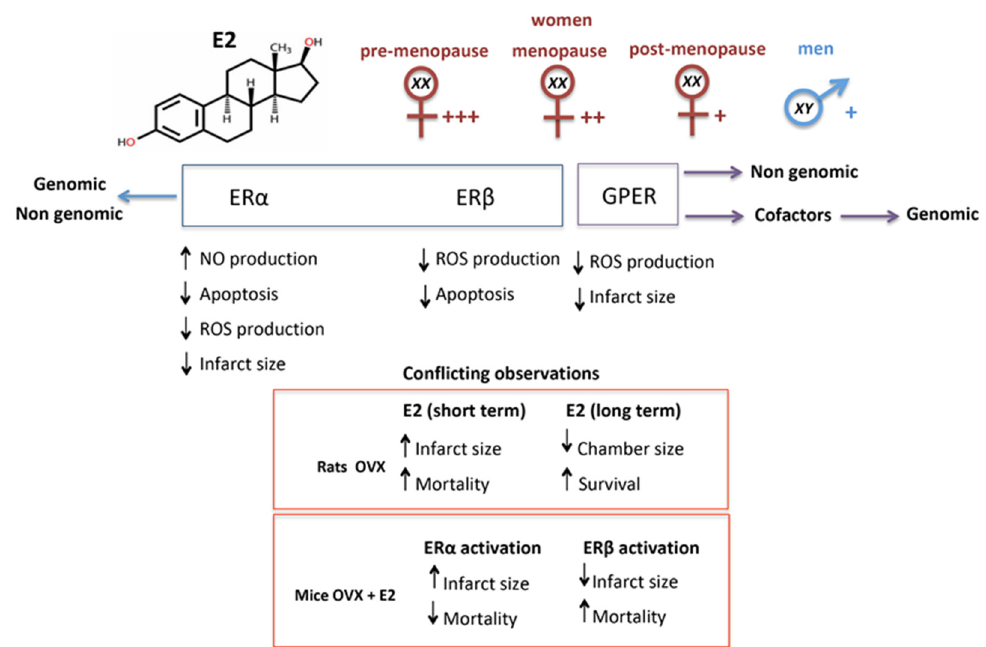
Figure 2. Schematic representation of the role played by estrogen in cardiac repair and of the effects mediated by specific receptors. E2 through its interaction with the different receptors (ER α , ER β or GPER) can induce different effects, which can be genomic and/or non-genomic. Importantly, E2 levels vary by sex and, especially in the case of females, by age. Postmenopausal women may have E2 levels similar to those found in men. Furthermore, E2 can sometimes induce discordant effects based on the experimental models used. E2, estradiol; GPER, G protein-coupled estrogen receptor; OVX, ovariectomized; NO, nitric oxide; ROS, reactive oxygen species.